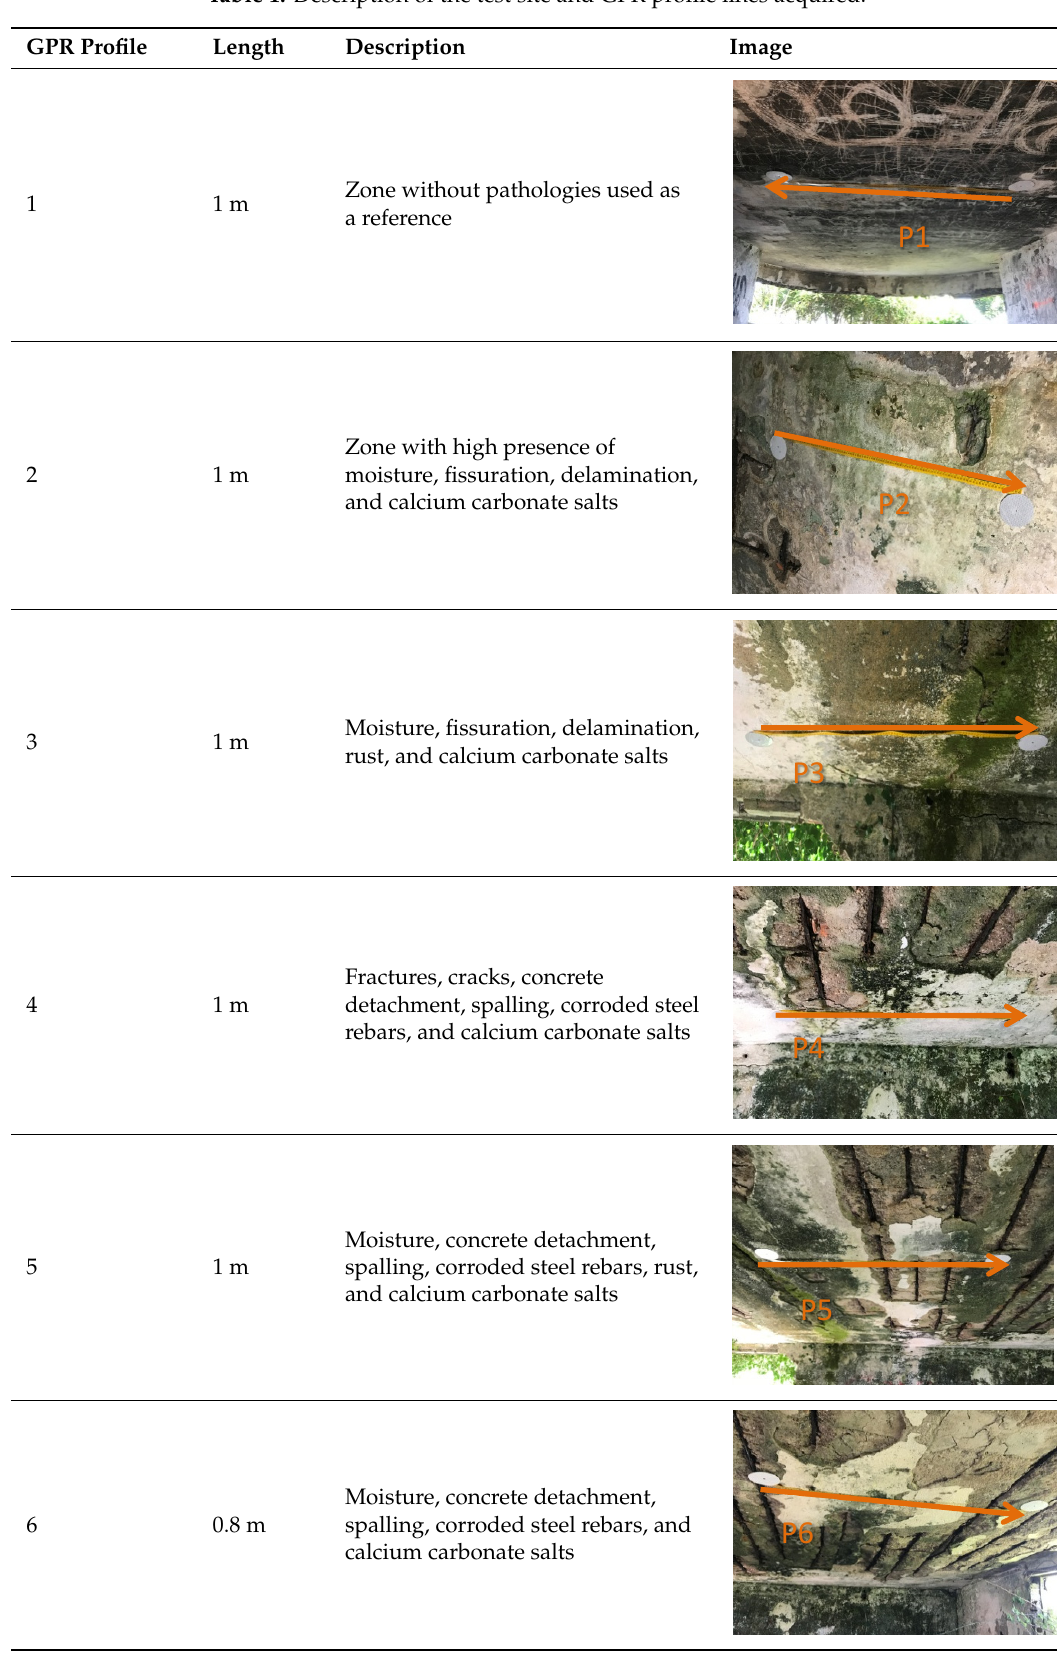
Table 1. Description of the test site and GPR profile lines acquired.